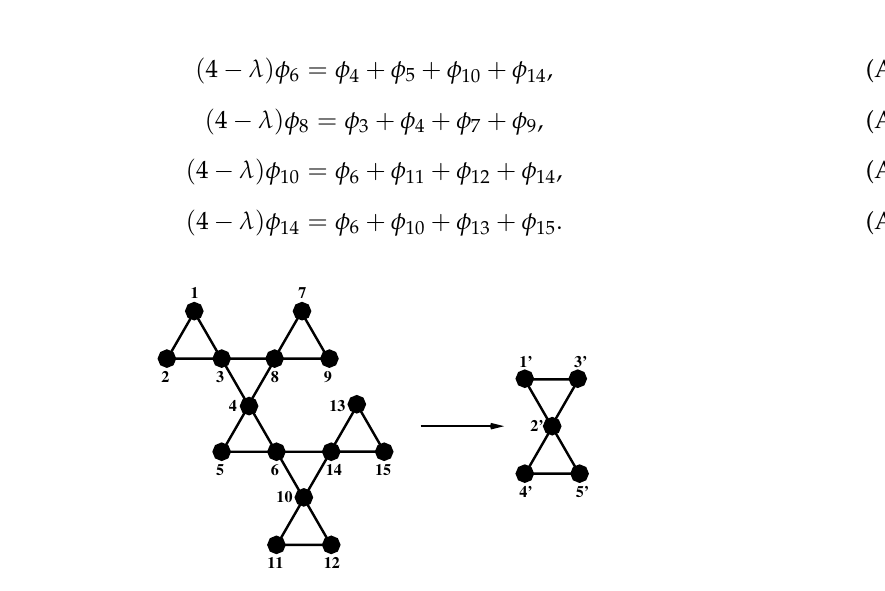
Figure A2. Second